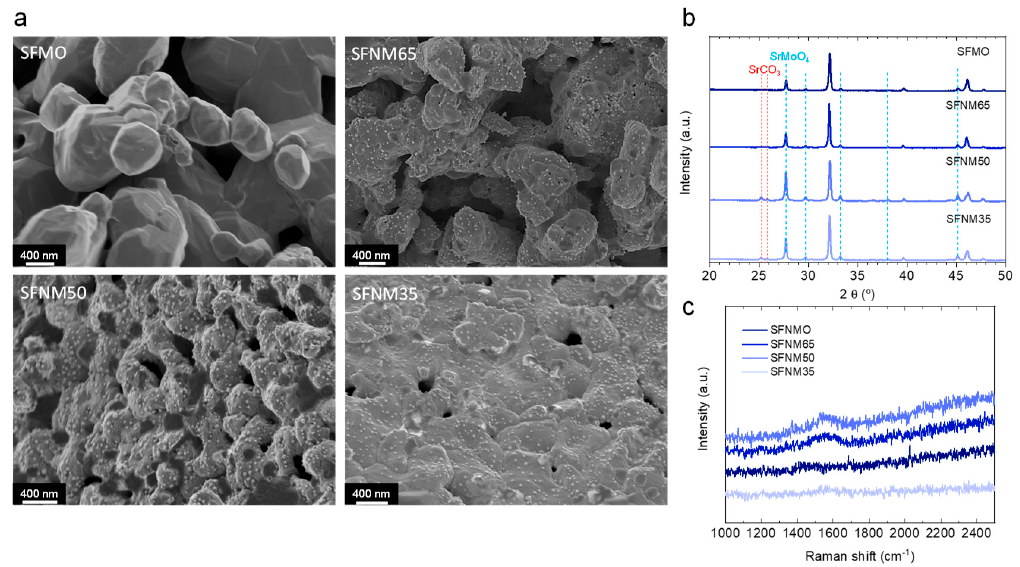
Figure 8. ( a ) SEM images, ( b ) XRD patterns, and ( c ) Raman spectra of the four Sr 2 Fe x Ni 1-x MoO 6- δ samples after the reaction (850 °C, 10 h, 5%vol. CO 2 , 5%vol. CH 4 , 100 mL min − 1 of total flow). Figure ( c ) depicts the 1000–2500 cm − 1 region to show the modes associated with carbon deposition.